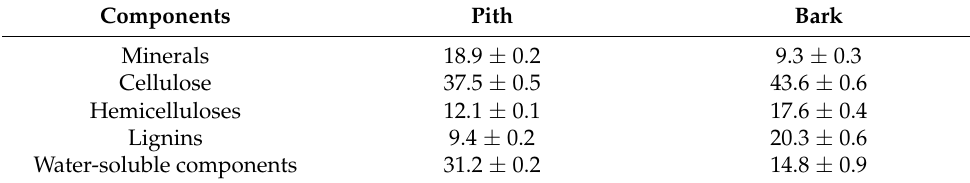
Table 3. Chemical composition of pith and bark from amaranth stem (% of the dry matter).